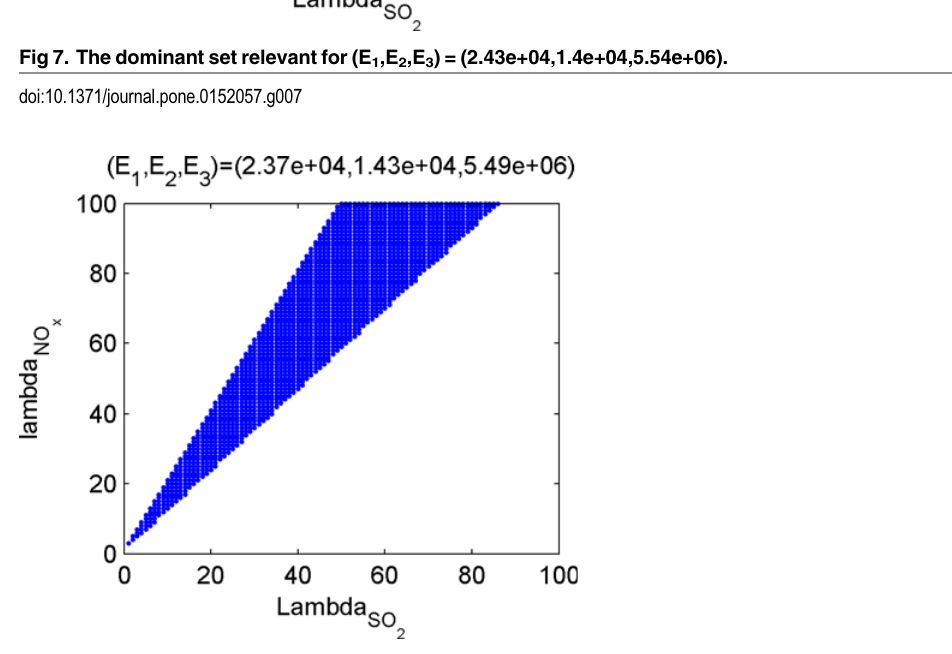
Fig 8. The dominant set relevant for (E 1 ,E 2 ,E 3 ) =